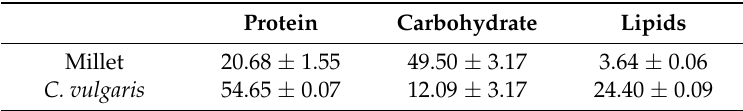
Table 3. Proximate composition of C. vulgaris and millet used in formulating diet for African catfish C. gariepinus